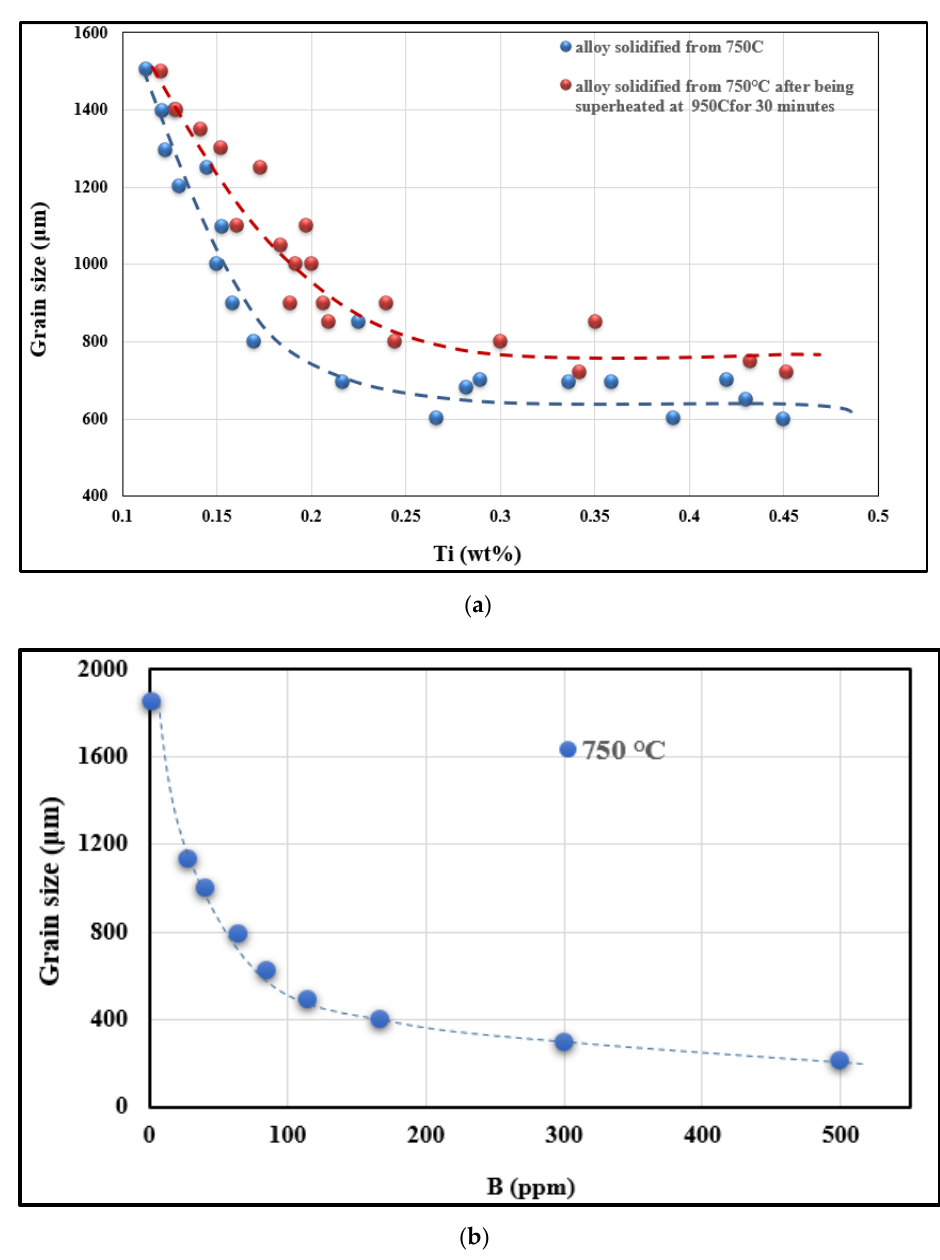
Figure 10. ( a ) Effect of the added Ti content and casting procedure on the alloy grain size. ( b ) Effect of the added B content on the alloy grain size.